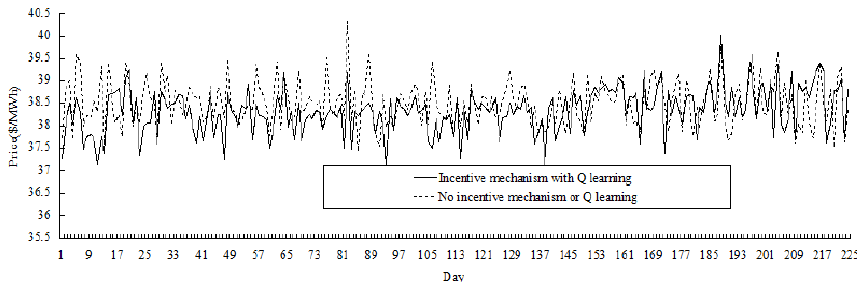
Figure 8. Comparative results of average cost variation (for 16 periods).